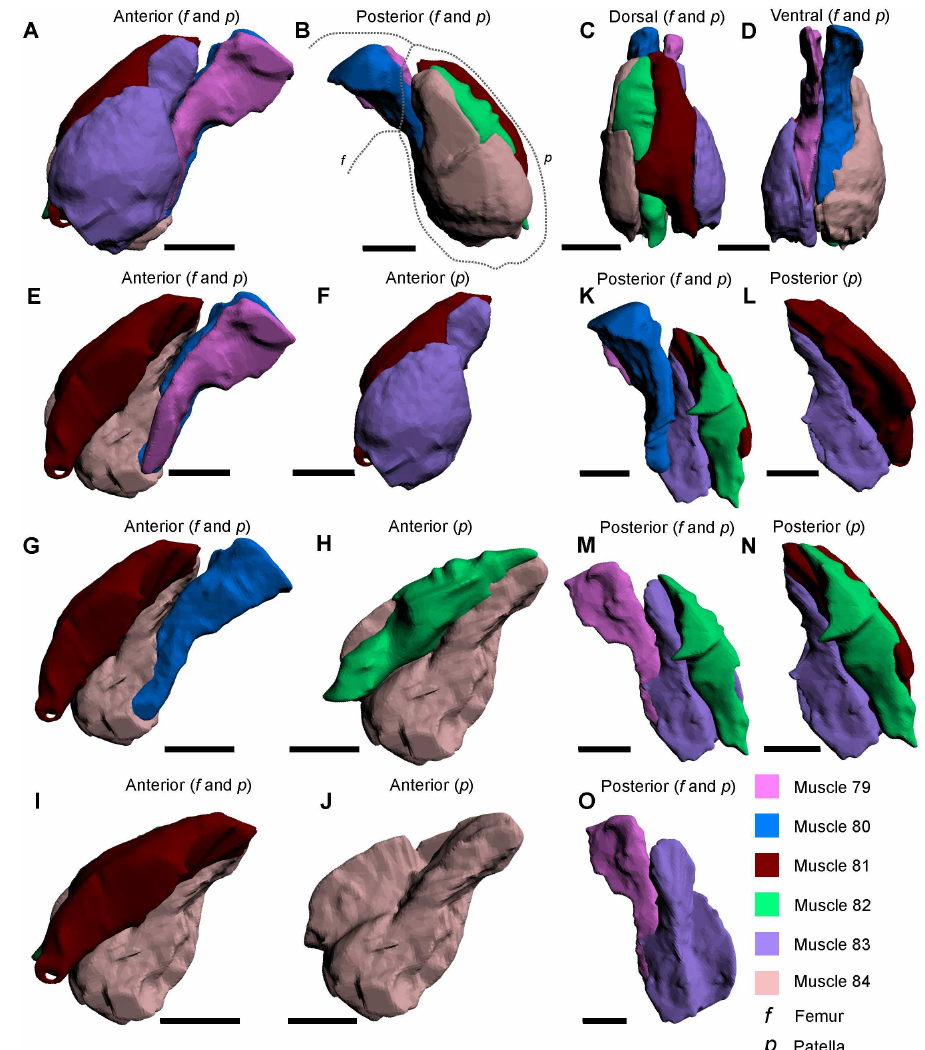
Fig 7. The muscles within the walking legs and male pedipalp patella, as modelled from iodine staining and micro-CT–scanning. The illustrated muscle reconstructions were selected from the male pedipalp 3D PDF (S4 Fig), as these reconstructions are the most anatomically informative. A–D depict the six muscles in four views to illustrate the overall form of the muscles and their relative positions to each other. The muscles (E–O) are shown in anterior and posterior views to accurately display the main features and shapes thereof and, where possible, their position relative to adjacent muscles. The dotted lines in B outline the distal end of the femur and the patella. All scale bars 5